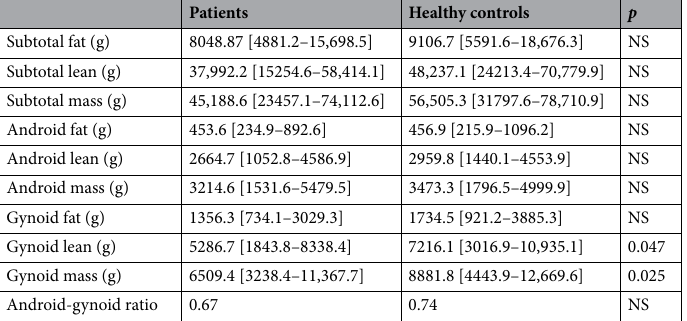
Table 4. Comparisons of data measurements of body composition by DXA between patients and healthy controls. Results as median [min–max], BMC: bone mineral content, BMD: bone mineral